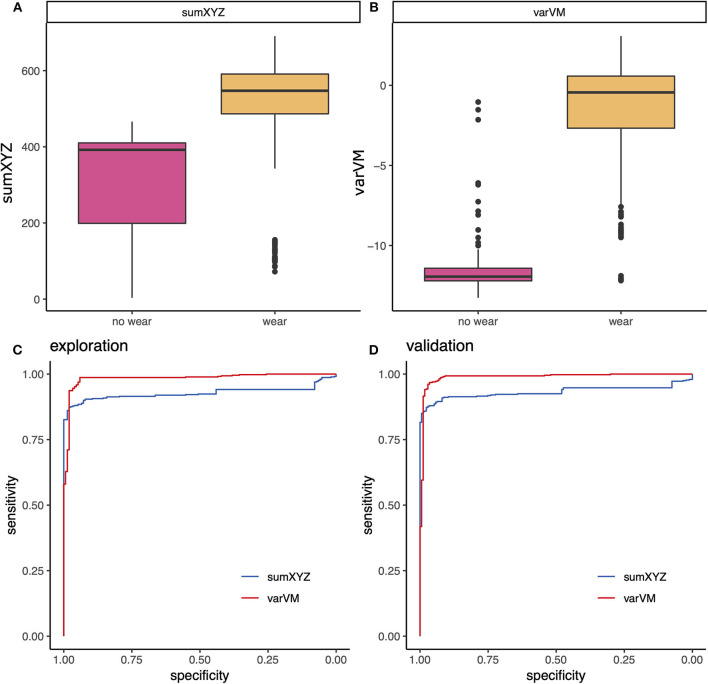
Technical validation of smartphone metrics: wear time detection. Exploration of different smartphone metrics revealed good discriminant abilities for (A,B) sumXYZ and varVM that could be confirmed in receiver operating characteristic (ROC) analyses of the (C) explorative and the (D) validation subset.